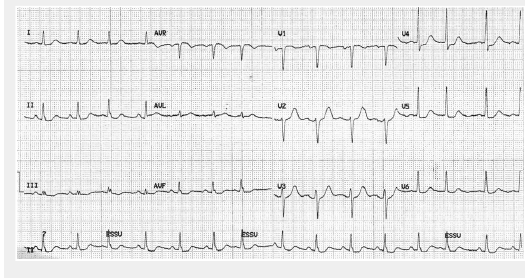
CMR and DE-CMR images. Fig. 2A: Short axis view of left ventricular myocardium without contrast showing an aspecific hypocaptation in the infero-basal portion. Fig. 2B: Long-axis DE- CMR images showing no late